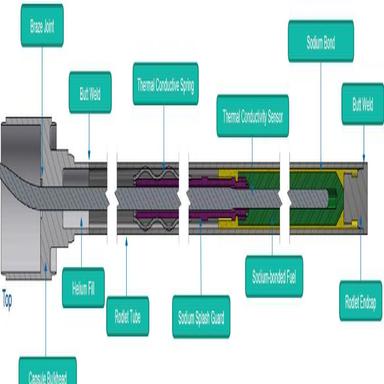
Shows a cross-section view of the IMPACT sodium-bonded rodlet assembly.